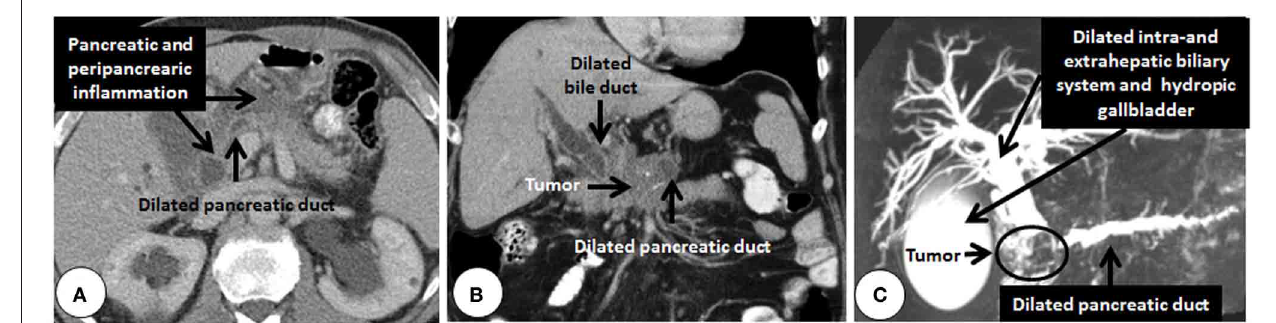
pancreatic-ducts failing to merge. The locally advanced tumor is not directly visible in the background of pancreatitis (calcifications appear as white spots in the pancreatic head). (C) Reconstruction of T2-weighted imaging (magnetic resonance cholangio-pancreatography) showing the same phenomenon in another patient (fluids appear white in T2-weighted